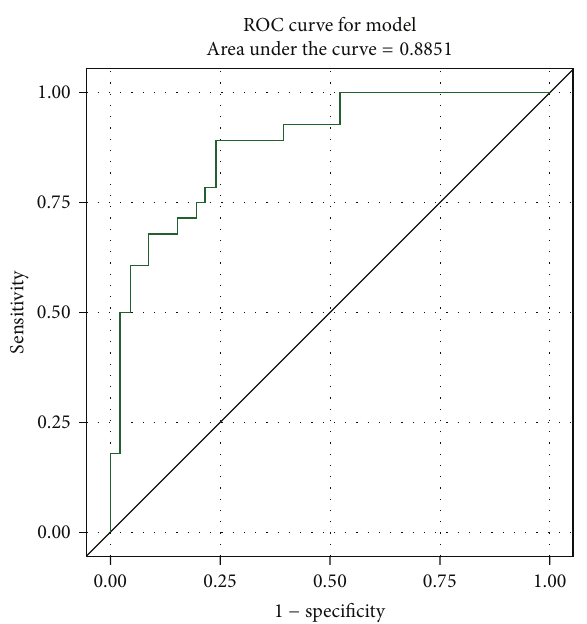
Figure 1: ROC curve for the reduced multivariate logistic regression model comparing patients with psoriasis and the control